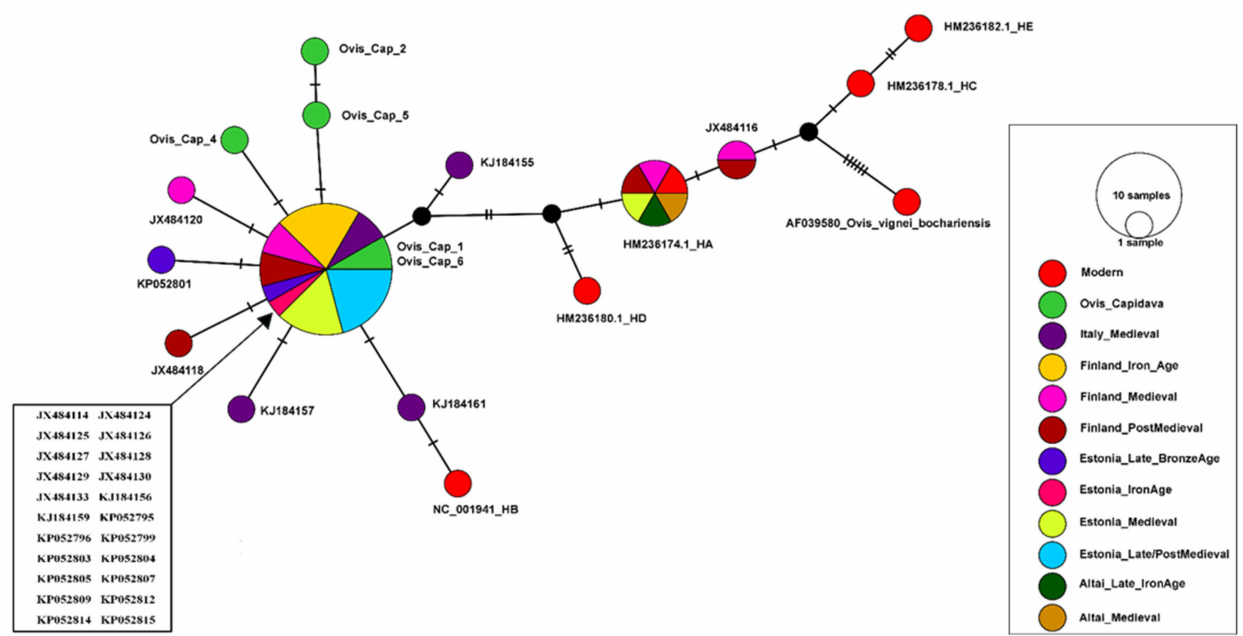
Figure 2. MJ Network illustrating the position of the Capidava cohort relative to the five Ovis aries haplogroup reference sequences and 41 ancient sequences grouped according to geographical origin and historical period, performed on a 304 bp region, nucleotide positions 16099 to 16402 (NC_001941). Node size is proportional to the number of sequences, as indicated in the figure legend. Cross lines represent the number of mutations. Branch length is not